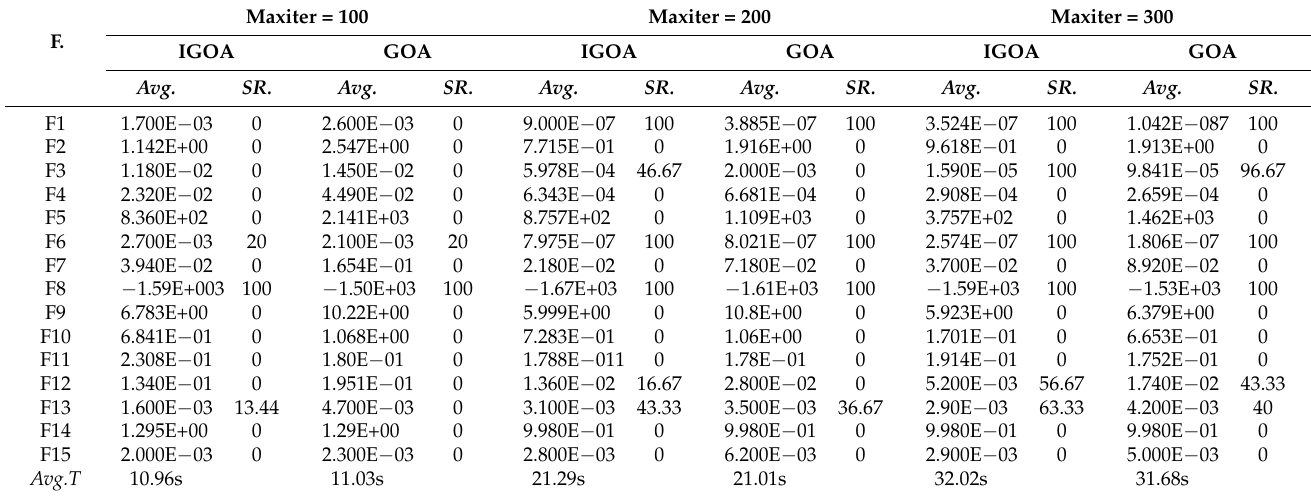
Table 4. The effects of the Maxiter on optimization